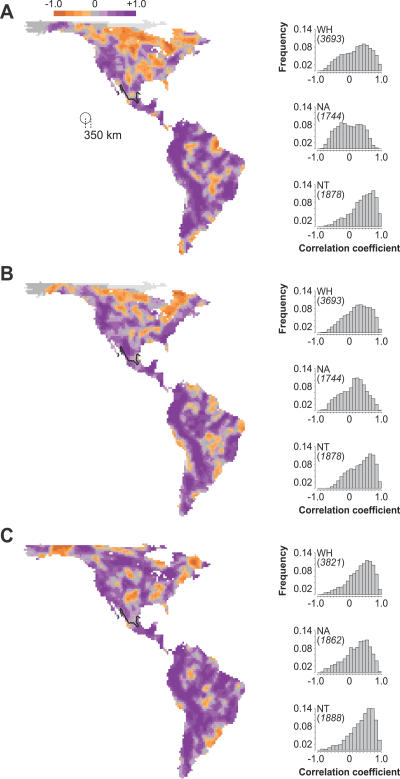
Geographic Variation in Beta-Diversity Congruence of Amphibians, Birds, and Mammals at Small Spatial ExtentsThe color of each grid cell indicates the strength of beta-diversity (βsim-d) congruence calculated within a 350-km-radius window around that grid cell. Orange shades represent strong (darkest) to weak (lightest) negative correlations. Purple shades show strong (darkest) to weak (lightest) positive correlations. Dark gray indicates very weak correlations of either sign, or no correlation. Light gray grid cells do not contain amphibian species. Shown to the right of each map are frequency distributions of correlation coefficients for windows located within the entire Western Hemisphere (WH), the Nearctic realm (NA), and the Neotropical realm (NT), which are consistent with the overall level of congruence measured at these extents. The black line marks the boundary between the two realms. (A) Amphibians and birds. (B) Amphibians and mammals. (C) Birds and mammals.